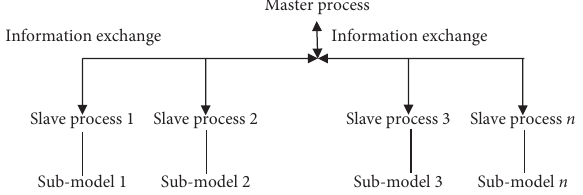
Figure 8: The diagram of parallel computing architecture.